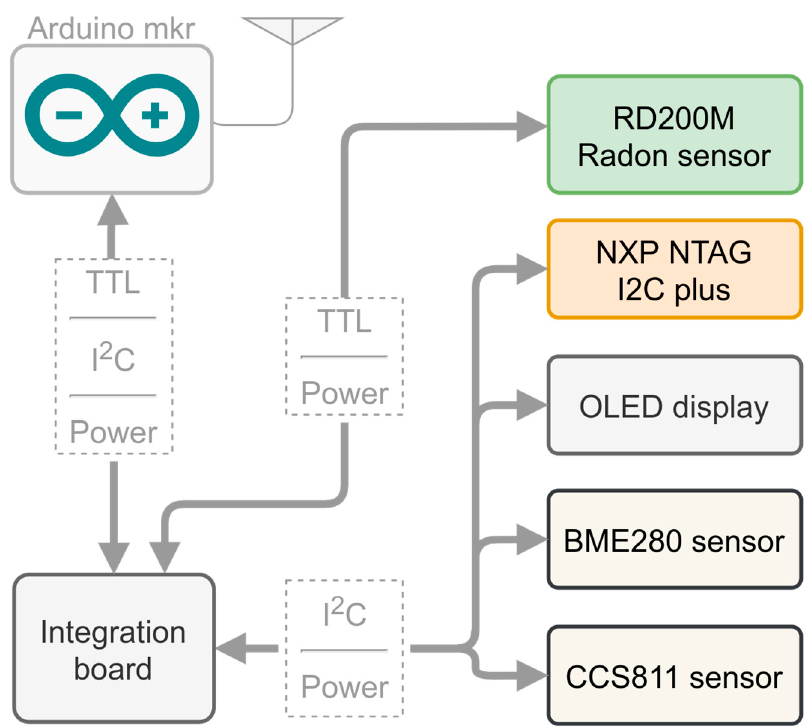
Figure 4. Sketch of the devices developed: processing unit and antenna, integration board, RD200M radon sensor, OLED screen, NXP NTAG I 2 C plus, CCS811 sensor and BME280 sensor.